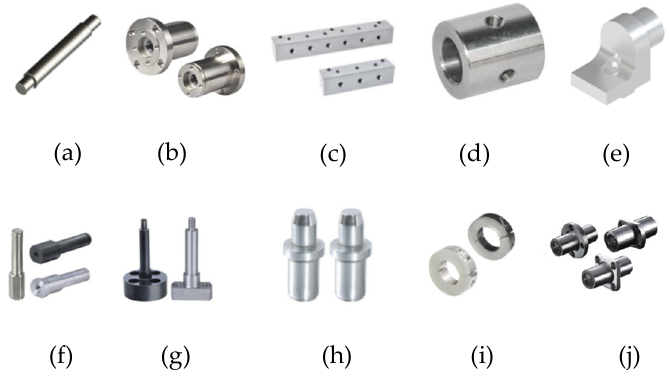
Figure 9. Some actual 3D parts(a - j represent different parts).